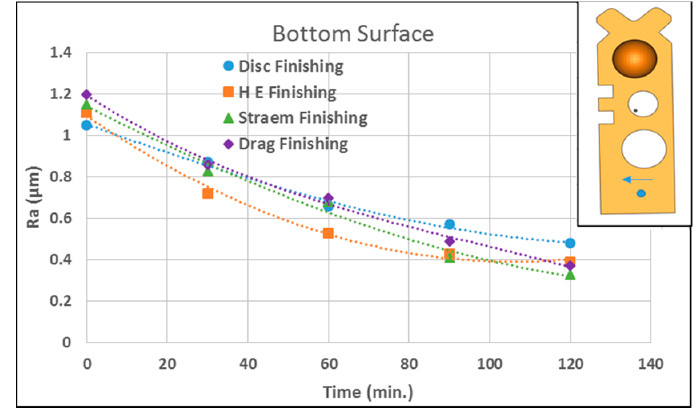
Figure 9. Surface roughness comparison on top surface (blue arrows show direction of measurement).